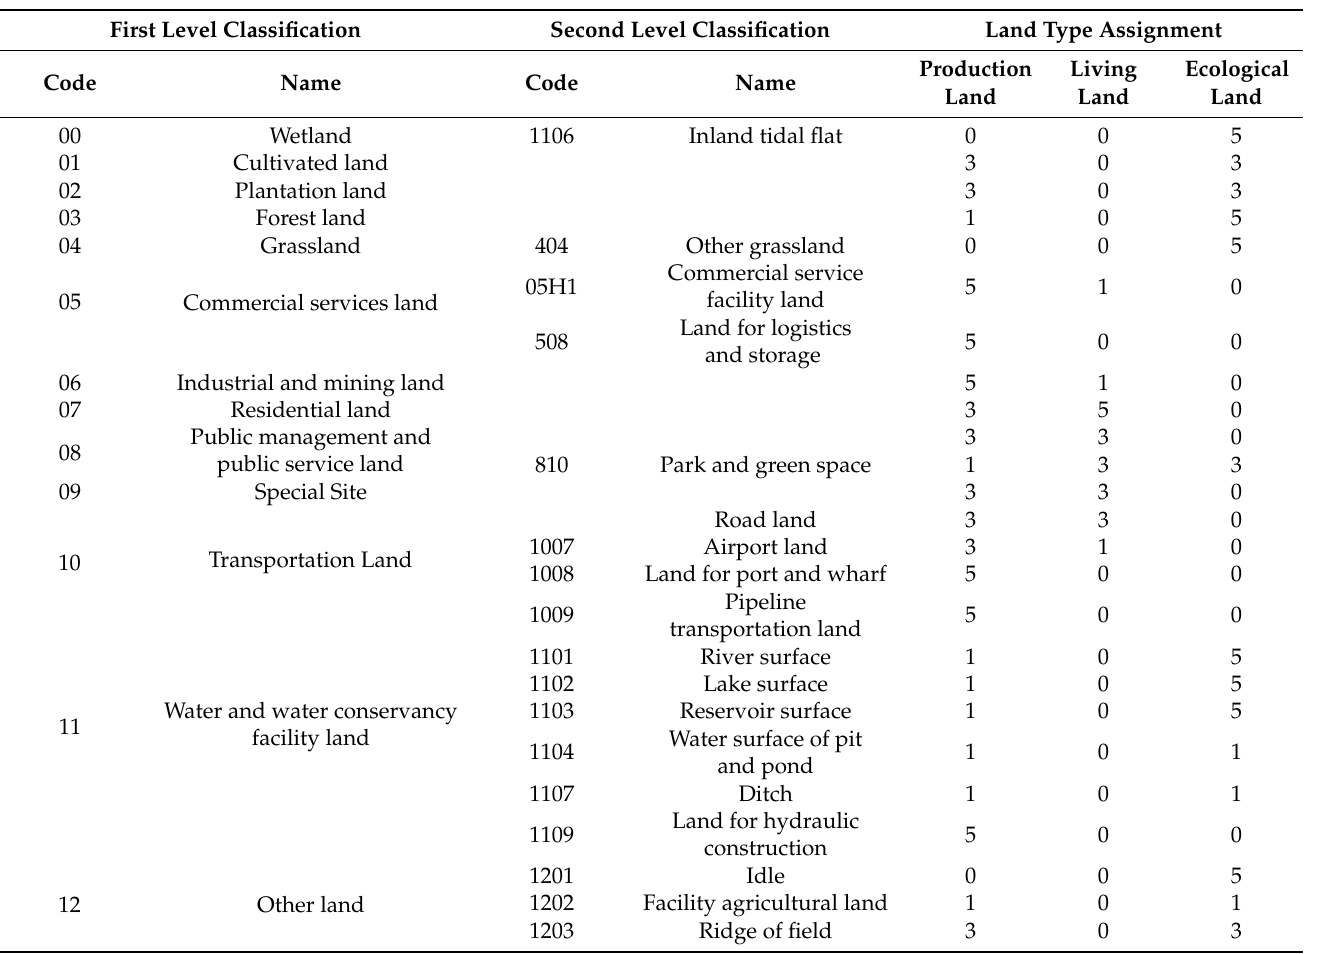
Table 2. Spatial membership degree and assignment of production–living–ecological space based on land use